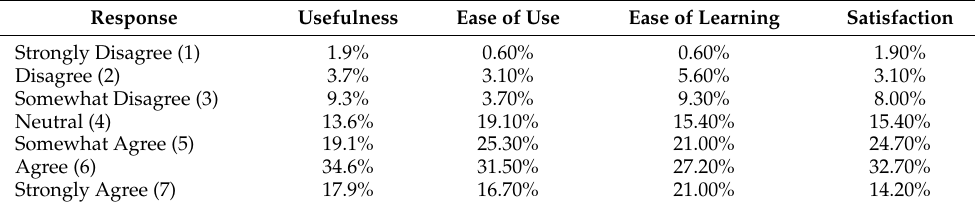
Figure 3. Bar chart display of experimental group participant responses on the feasibility and acceptability on the oral HIV self-testing infographic questionnaire ( n = 161).